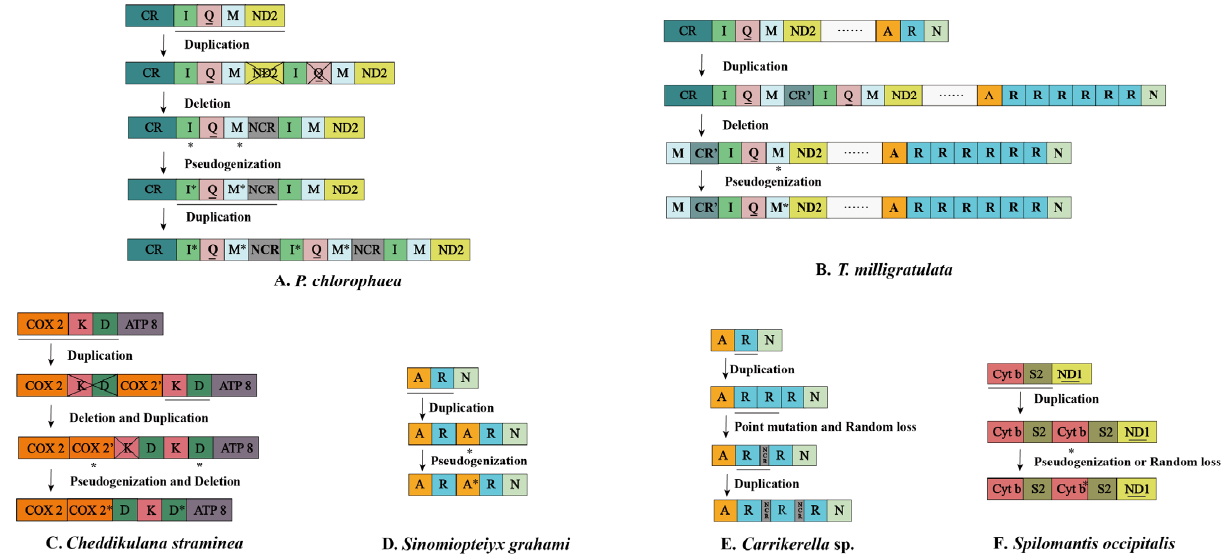
Figure 1. Six mantis mitogenomes with putative mechanism of gene rearrangements. The size of the genes is not proportional. Genes with underlines encoded by the N-strand and those without underlines are genes encoded by the J-strand. Asterisked genes indicate pseudogenes. The remaining genes and gene orders are excluded that were identical to those of the ancestral insect. Horizontal lines, asterisk symbols, and crossed-out colored boxes represent gene duplications, gene pseudoge- nization, and gene deletions, respectively. ( A ) Theopompa milligratulata , ( B ) Pseudovates chlorophaea , ( C ) Cheddikulama straminea , ( D ) Carrikerella sp., ( E ) Sinomiopteryx grahami , ( F ) Spilomantis occipitalis